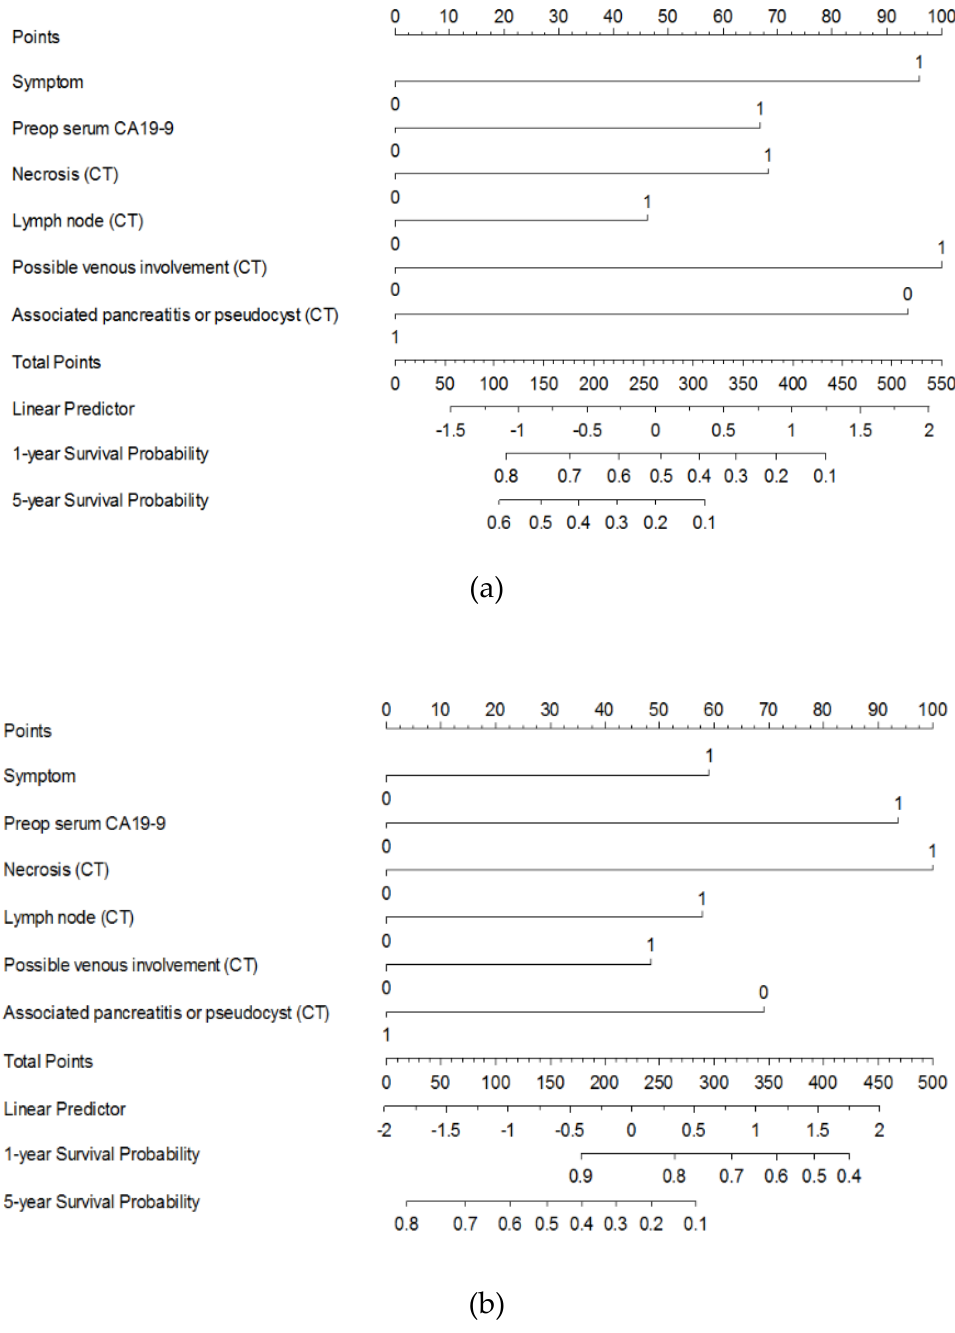
Figure 1. Nomogram predicts probability of ( a ) disease-free survival and ( b ) overall survival one year and five years after curative-intent surgery for radiologically resectable or borderline resectable pancreatic head cancer. The points of each predictor found on the uppermost point scale were added up and the total sum projected on the bottom point scale indicates the probability of ( a ) disease-free and ( b ) overall survival for each time point. The serum CA 19-9 was dichotomized at 34 U / mL by the log-rank test; CA 19-9, carbohydrate antigen 19-9; CT, computed tomography; 0, Negative; 1, Positive.